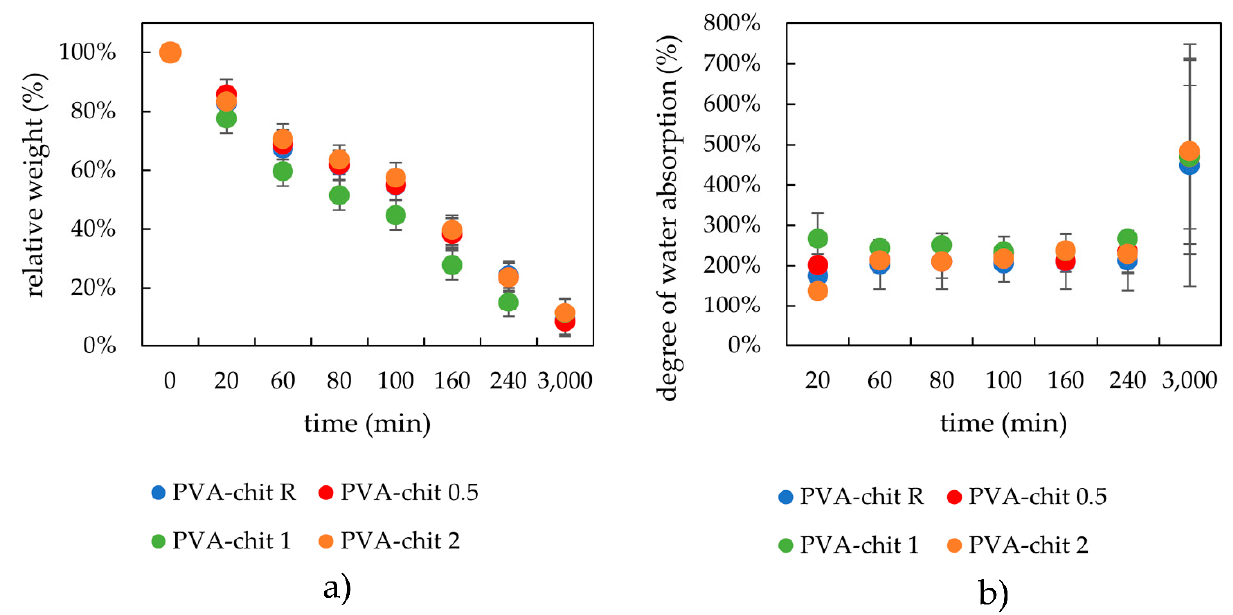
Figure 8. Drying ( a ) and rehydration ( b ) of chemically crosslinked PVA-chitosan hydrogels with different lecithin content.